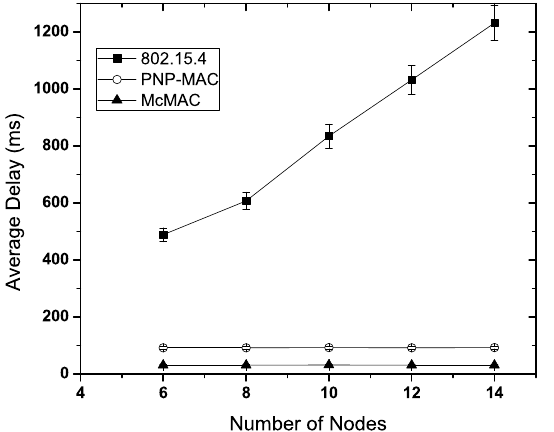
Figure 15. Average latency of emergency packet at varying number of